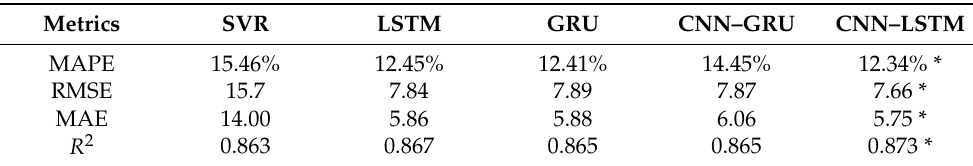
Table 2. Performance comparison of different models under study in terms of the used state-of-the-art metrics on the traffic flow dataset.